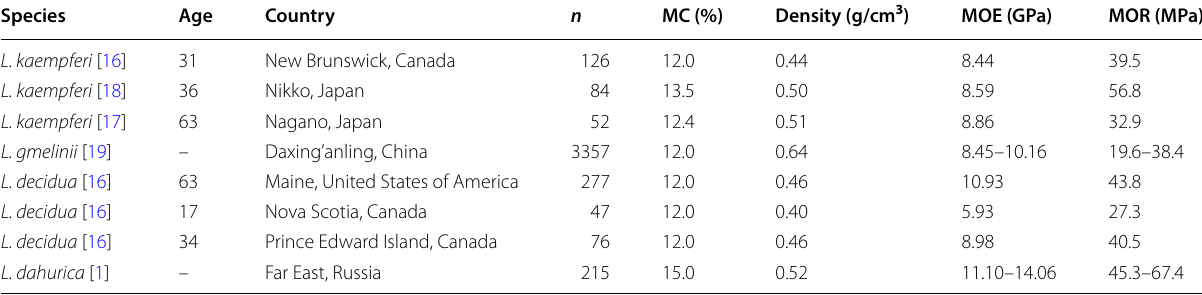
4 lumber produced from the trees of other Larix species ×